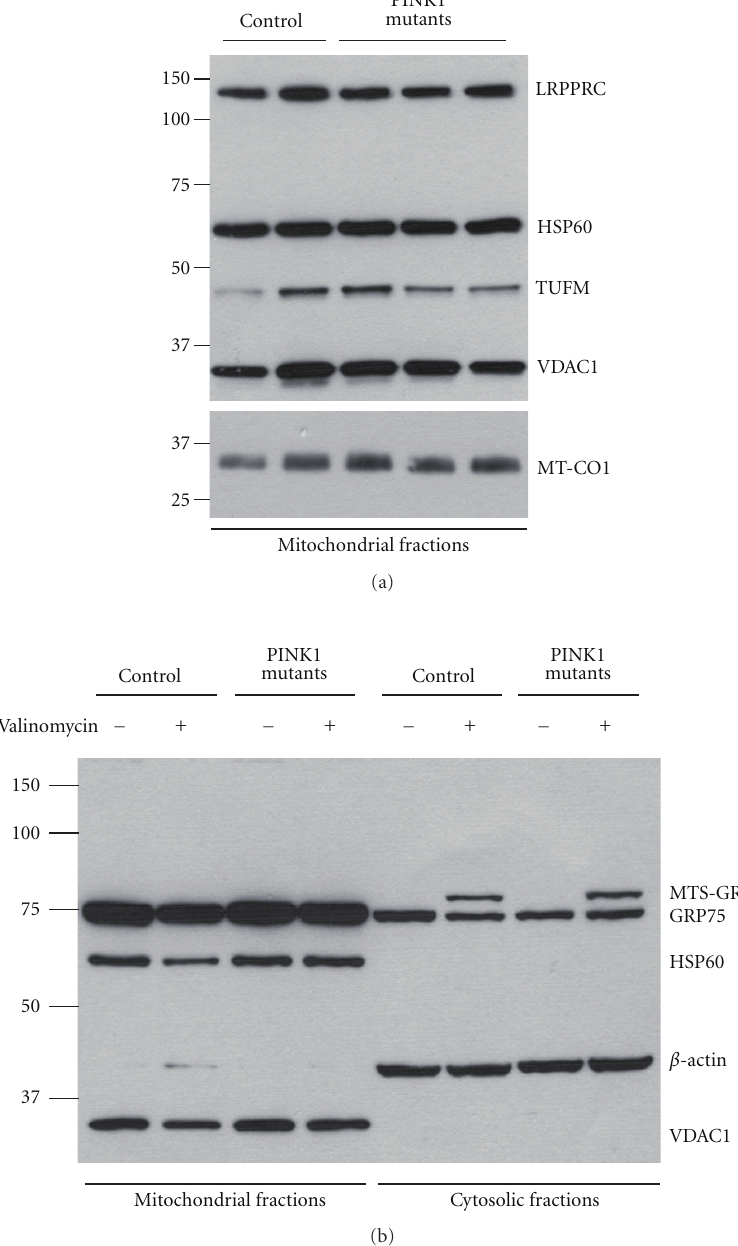
Figure 3: Cellular abundance of potential mitochondrial PINK1-interacting proteins. Mitochondrial and cytosolic fractions from fibroblasts were analyzed by Western blotting using antibodies against HSP60, LRPPRC, TUFM, MT-CO1, and GRP75. (a) The mitochondrial localization of LRPPRC and TUFM was confirmed, and no di ff erences in their cellular abundance were detected when comparing PINK1 mutants and controls. Furthermore, the level of LRPPRC-associated MT-CO1 was not altered in PINK1 mutants. (b) In the mitochondrial fractions, the abundance of (processed) GRP75 was comparable in PINK1 mutants and controls under basal and valinomycin stress conditions (1 μ M for 24h). In the cytosol, an additional band representative of accumulation of nonprocessed MTS-GRP75 was detected when cells were treated with the mitochondrial membrane inhibitor valinomycin. Due to a possible contamination of the cytosolic fraction with mitochondria and/or partially cytosolic localization of GRP75, also the processed form of the protein is apparent in this fraction. The mitochondrial marker VDAC1 and the cytosolic marker β -actin served as loading controls. GRP75: 75kDa glucose-regulated protein; HSP60: Heat shock 60kDa protein; LRPPRC: Leucine-rich PPR motif-containing protein; MT-CO1: Mitochondrially encoded cytochrome c oxidase I; MTS-GRP75: GRP75 with mitochondrial targeting sequence; TUFM: Elongation factor Tu; VDAC1: Voltage-dependent anion channel